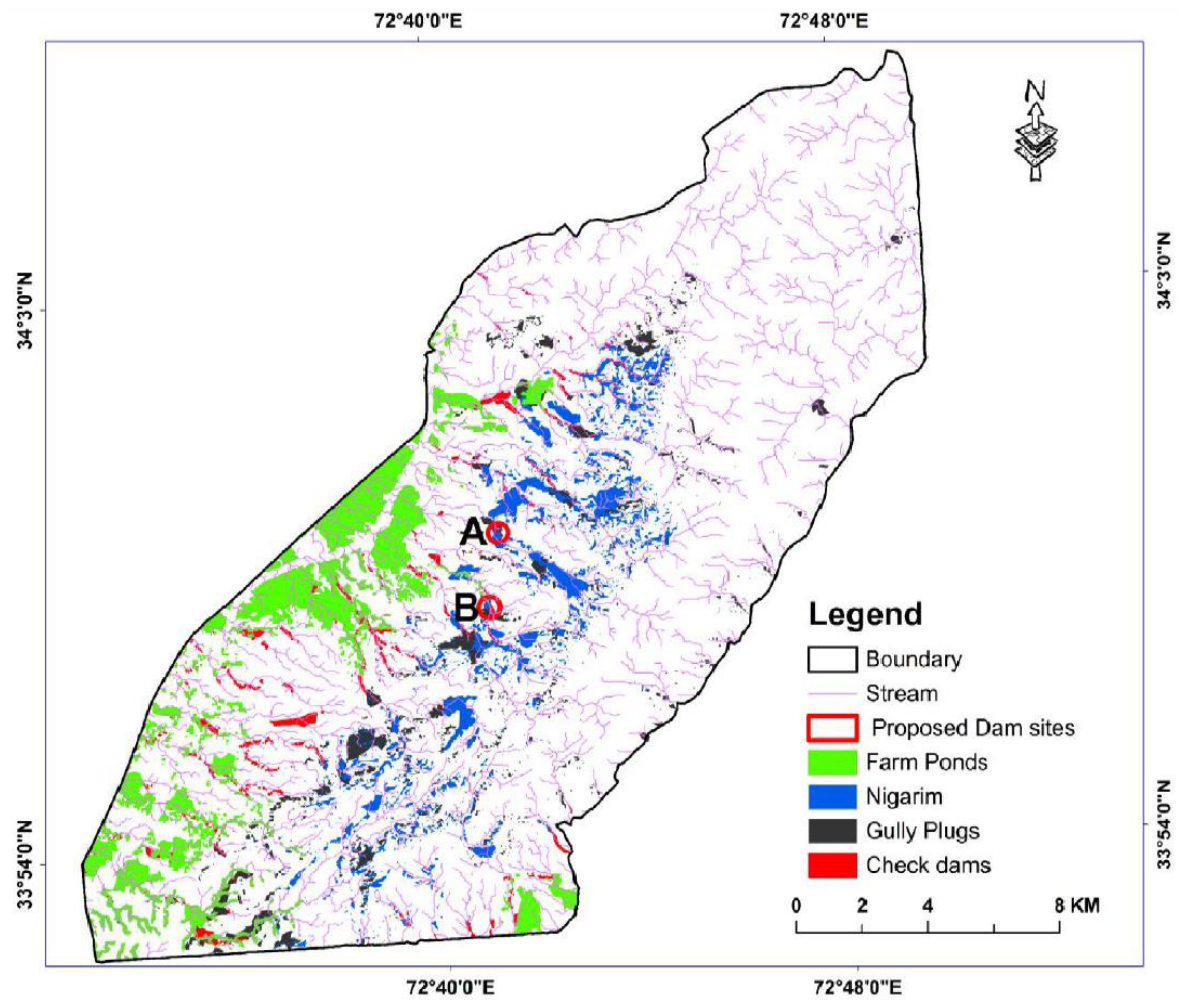
Figure 14. Composite map: suitable sites identified for construction of farm ponds, Nigarims, gully plugs, and check